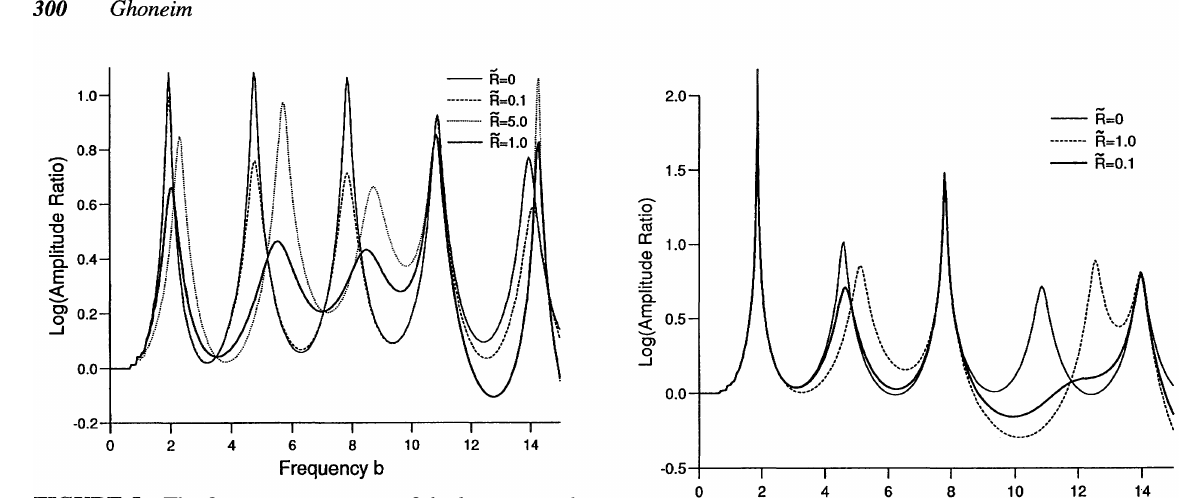
FIGURE 7 The frequency responses of the beam treated with an FSD element placed at fl.X = [0.4-0.6] for differ ent values of the nondimensional viscous damping, ii, and forC = If =0.